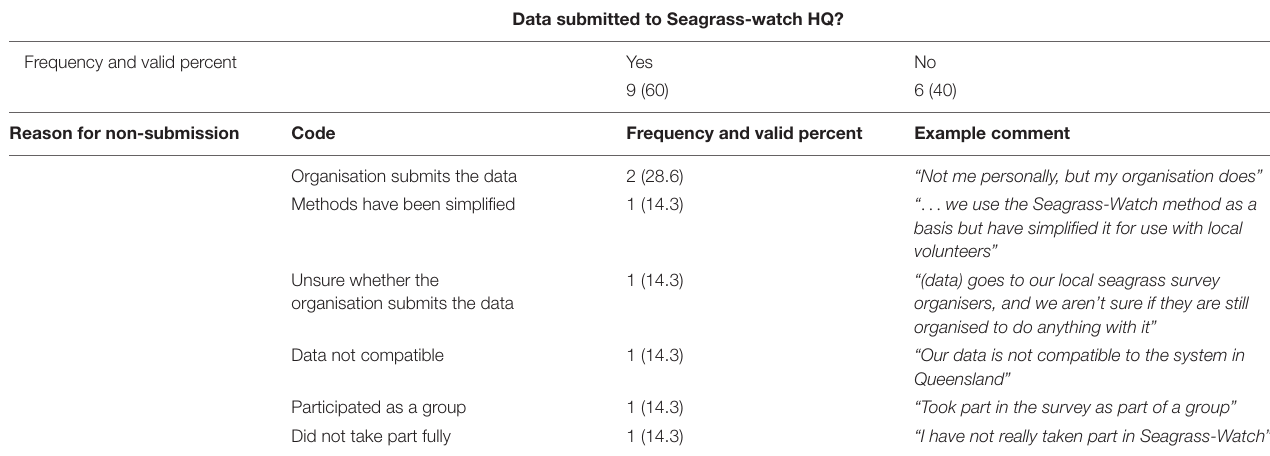
TABLE 5 | Proportion of Seagrass-Watch users who submit their data to Seagrass-Watch HQ and reasons for